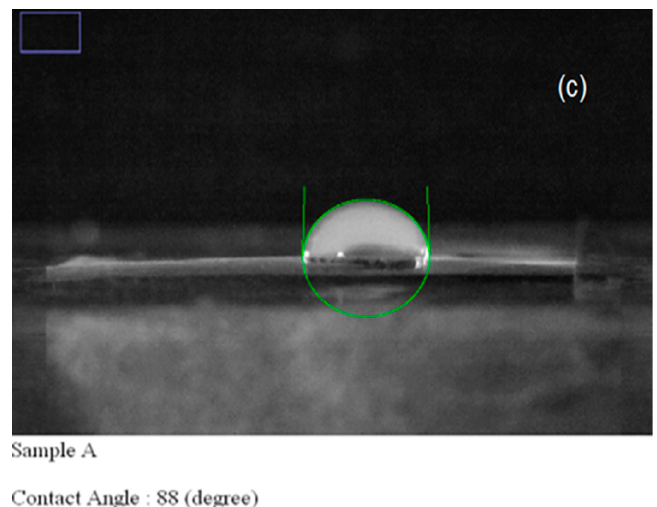
Figure 3. ( a ) SEM images, ( b ) fiber diameter distribution, ( c ) the contact angle of Bup/PVP nanofibers mat.